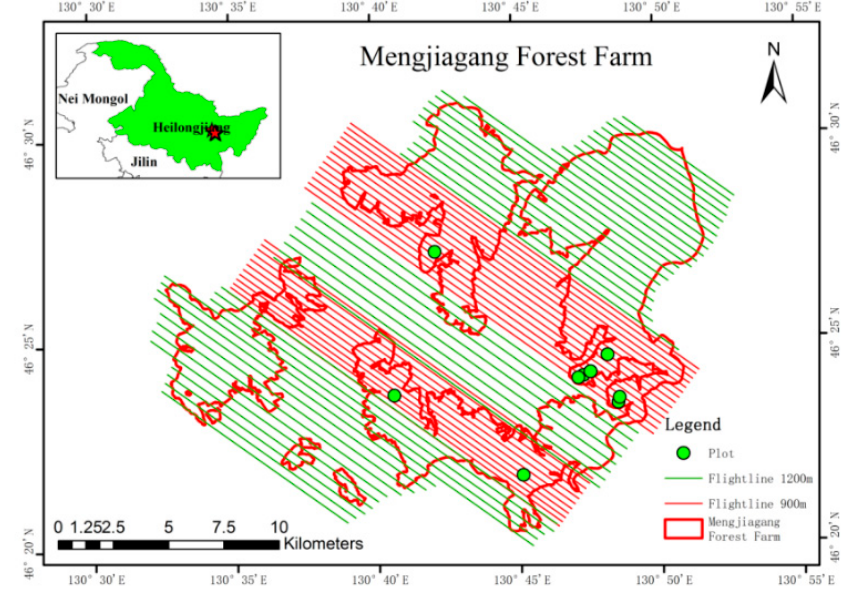
Figure 1. The location of field plots, and airborne laser scanning (ALS) flight lines in the Mengjiagang Forest Farm, Heilongjiang